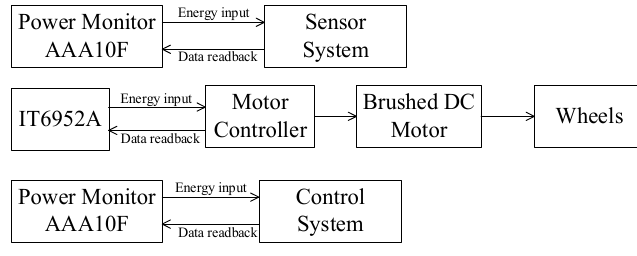
Figure 5. Power measurement system.